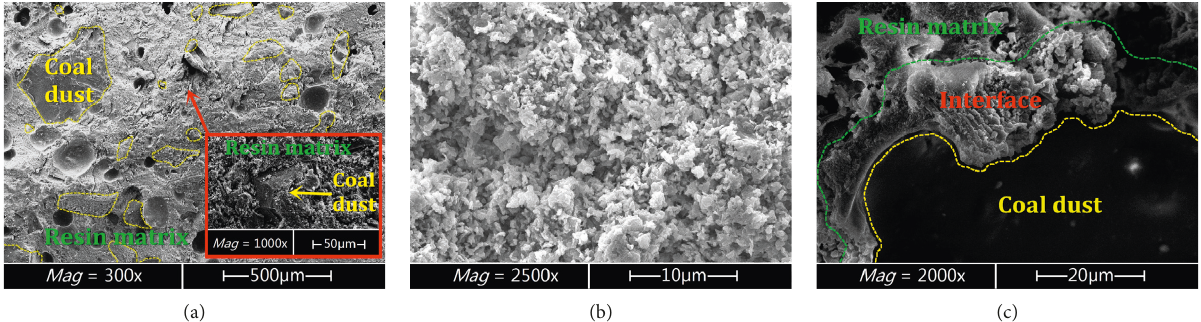
Figure 7: Microstructure of the composite material. (a) The CP material, (b) resin matrix, and (c) interface structure.